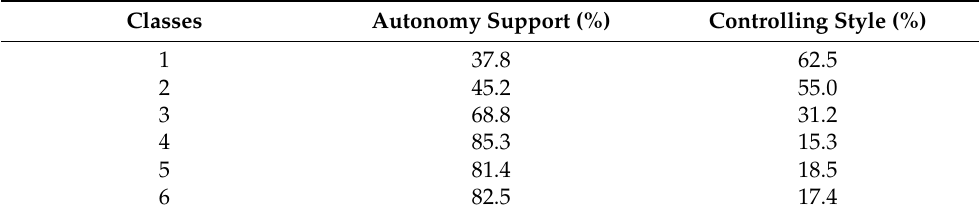
Table A5. Percentage of autonomy support and controlling